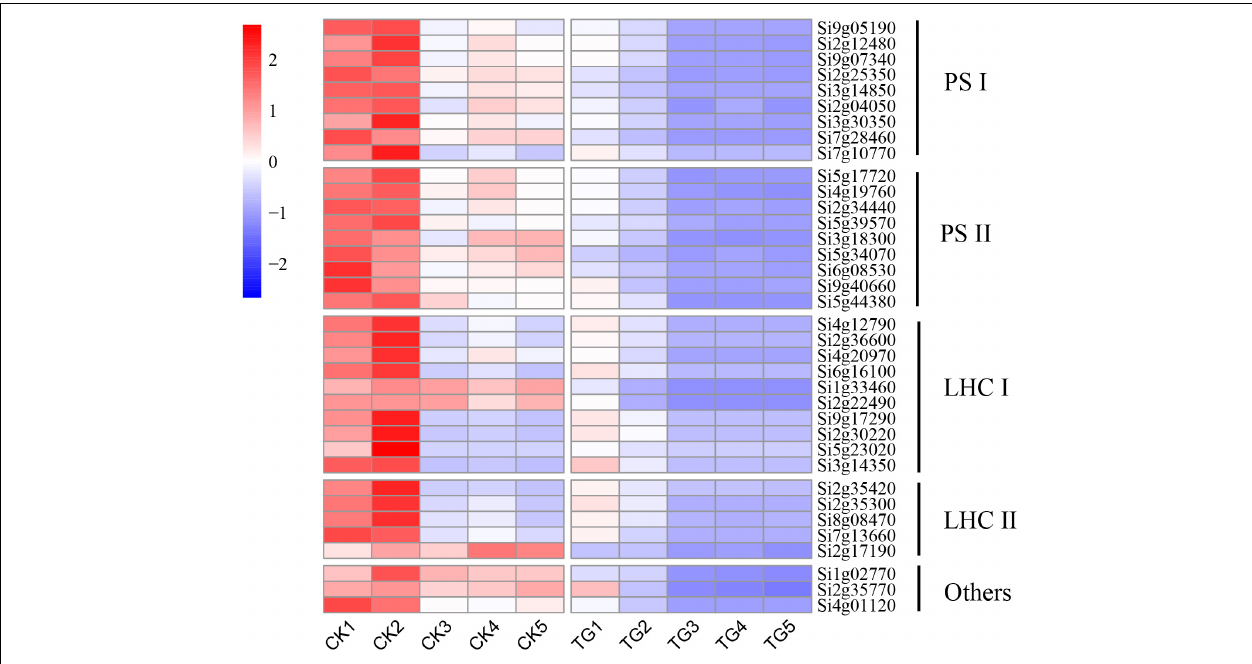
FIGURE 8 | The expression heat map of photosynthesis-related genes at different stages.